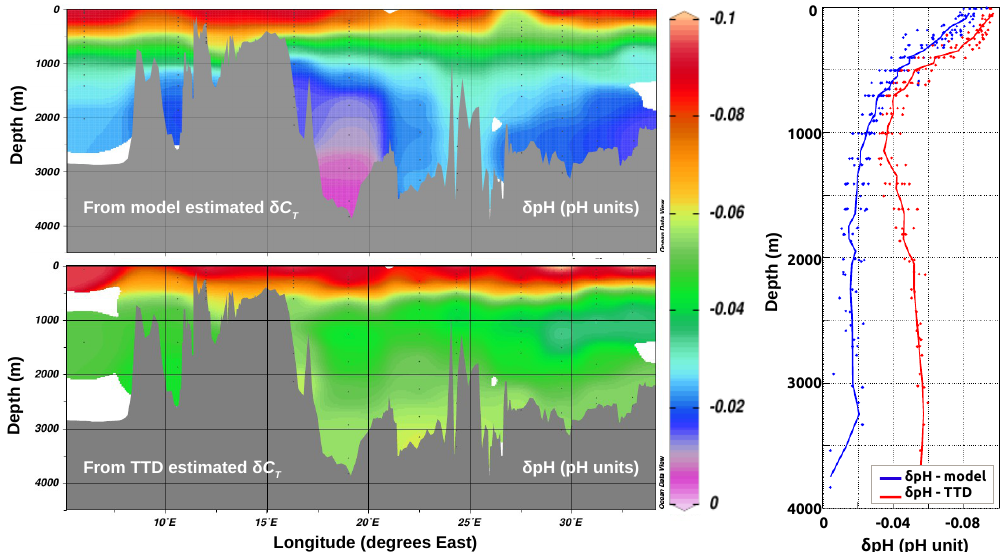
Figure 17. Mediterranean δ pH along the Meteor M51/2 section calculated with δC T from the MED simulation (top left) and from the TTD data-based estimates from Schneider et al. (2010) (bottom left). Also shown are the same results but as mean vertical profiles averaged along the section